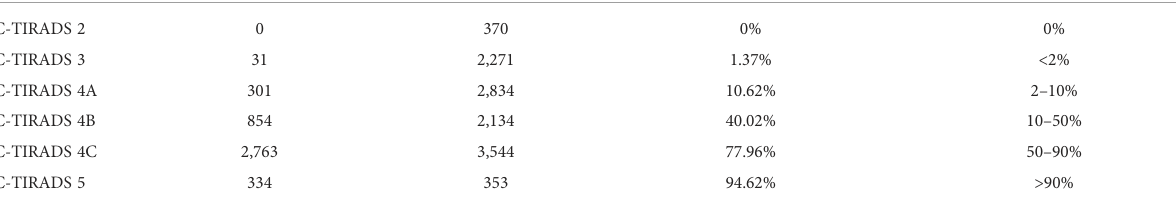
C-TIRADS, Chinese thyroid imaging reports and data